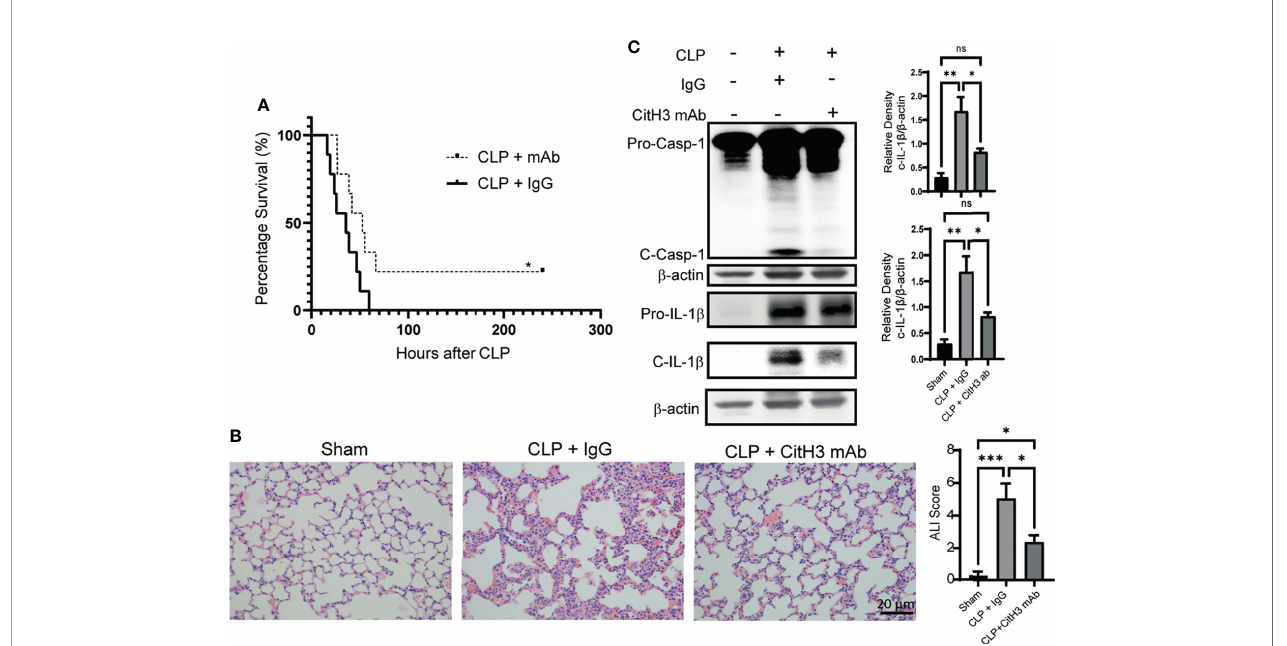
FIGURE 5 | Neutralization of CitH3 in murine CLP model decreases mortality and Caspase-1 induced lung injury. WT mice were subject to CLP model and then intravenously (4h after CLP) treated with 20 mg/kg IgG or CitH3 monoclonal antibody. (A) The survival curve of mice with or without CitH3 monoclonal antibody in CLP model (n = 9/group). (B) Representative histology images of murine lungs and ALI score following H&E staining in Sham, CLP with IgG or CitH3 monoclonal antibody treatment group at 24 h. (C) Representative Western blot images and densitometry quanti fi cation of activation of Caspase-1 (n = 3/group) and cleavage of IL-1 b (n = 4/group) in the lung tissues of Sham, CLP with IgG or CitH3 monoclonal antibody treatment group at 24 h. Data are expressed as mean ± SEM. *P < 0.05, **P < 0.01, ***P <0.001. ns, not signi fi cant; SEM, standard error of the